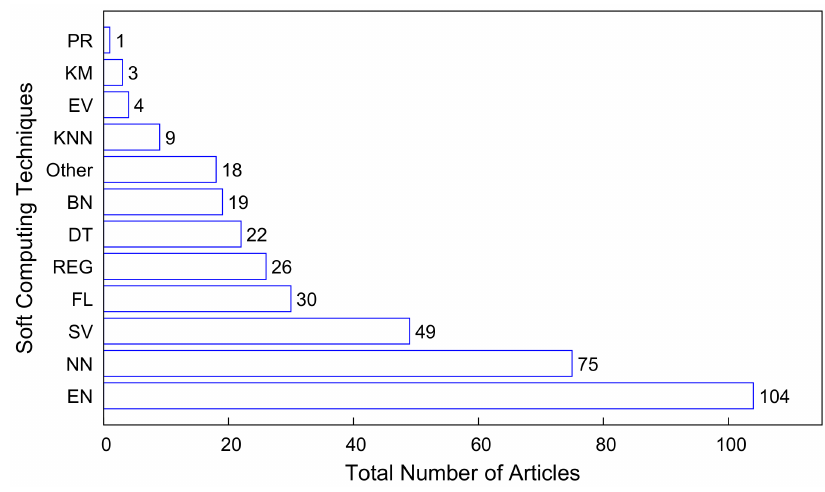
Figure 2. Frequencies of soft computing techniques covered in the studies.